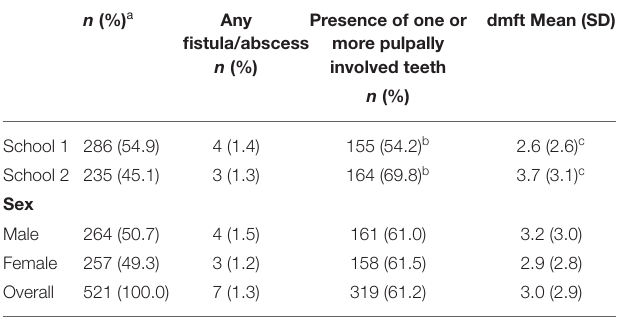
TABLE 2 | Sociodemographic characteristics and referral qualification of participants by clinical characteristics at baseline. n (%) a